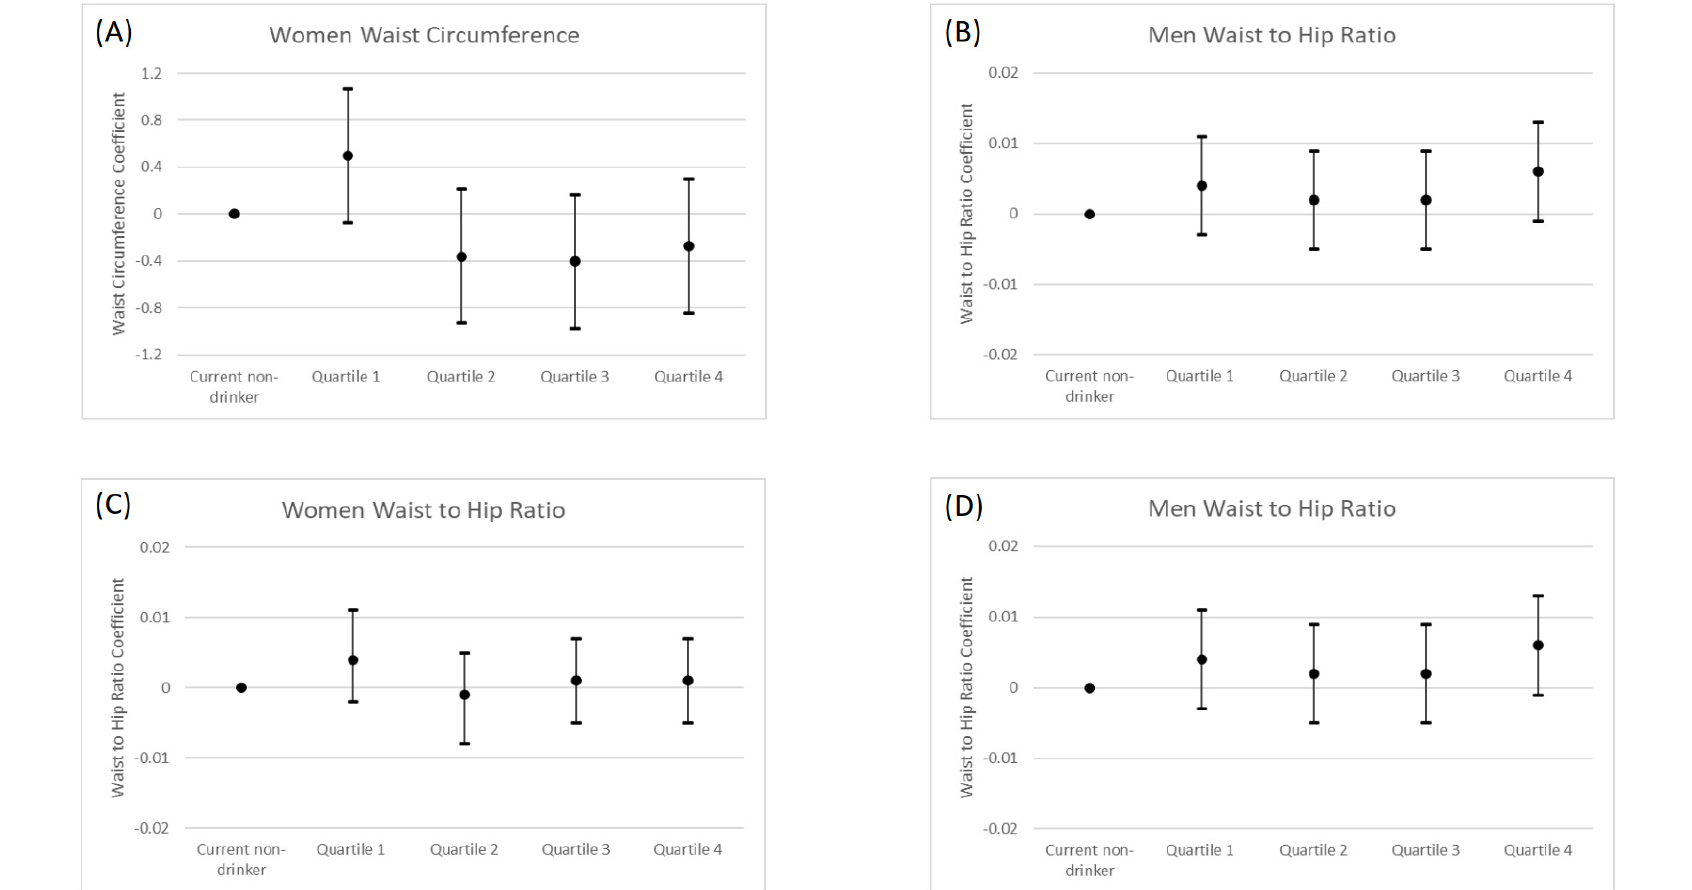
Figure 2. ( A – D ) Longitudinal associations between alcohol consumption and central adiposity by sex in the UK Biobank (Model 3). The coefficients were given in the Y -axis for each adiposity marker and display the mean difference between the reference category (current non-drinkers) and the other consumption categories. Model 3 is adjusted for baseline age, specific adiposity marker, follow up time (years), Townsend Deprivation Index, smoking status, major illness, sleep duration, PA, sitting time, and daily vegetable and fruit consumption. WC and hip circumference were measured by a trained professional by using flexible plastic tape with the participant in the resting-standing position. Alcohol consumption units by quartile: for women, 1st quartile: ≤ 1.3 unit; 2nd quartile: <6.9 unit; 3rd quartile: <14.3 unit; 4th quartile: ≥ 14.3 unit; for men, 1st quartile: ≤ 6.5 unit; 2nd quartile: <15.9 unit; 3rd quartile: <29.2 unit; 4th quartile: ≥ 29.2 unit.